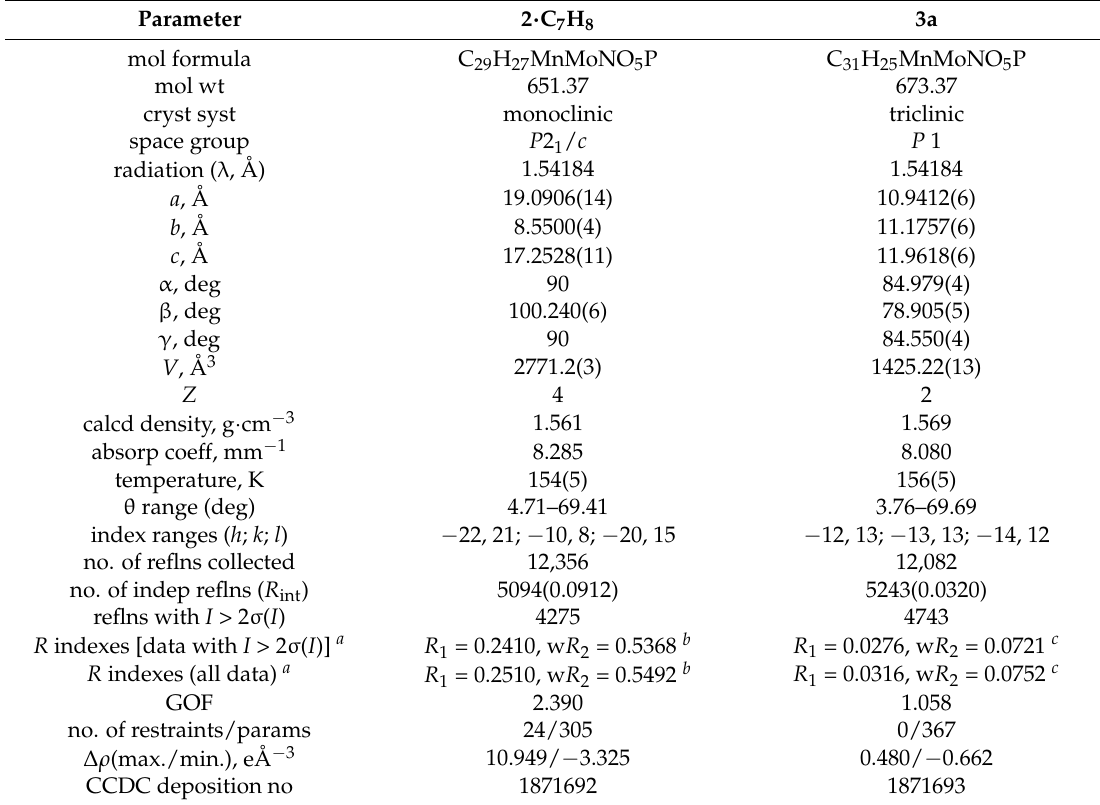
Table 3. Crystal Data for New